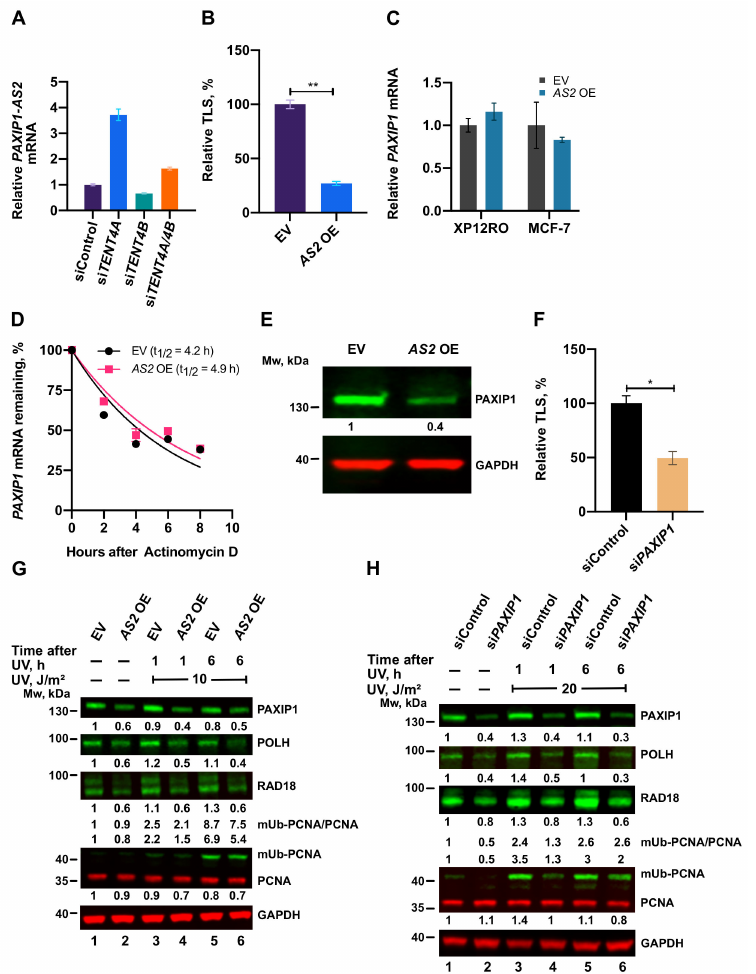
Figure 7. Involvement of PAXIP1-AS2 and PAXIP1 in TLS. ( A ) Expression of TENT4A and/or TENT4B . B was knocked down for 48 h, after which the level of PAXIP1-AS2 transcript was measured by qPCR, normalized to GAPDH , and compared to cells treated with siControl. The results are presented as the mean ± SEM of three independent experiments. ( B ) TLS across a cisPt-GG in MCF-7 cells in which PAXIP1-AS2 antisense RNA was overexpressed (See Supplementary Materials Tables S7 and S8). The results are presented as the mean ± SEM of two independent experiments. Statistical analysis was performed using the two-tailed Student’s t-test (** p < 0.01). ( C ) PAXIP1-AS2 antisense RNA was overexpressed in XP12RO or MCF-7 cells for 48 h, after which the amount of PAXIP1 mRNA was measured by qPCR, normalized to GAPDH and presented relative to cells transfected with an empty vector (EV). The results are presented as the mean ± SEM of three independent experiments. ( D ) PAXIP1-AS2 antisense transcript was overexpressed for 48 h in MCF-7 cells, after which PAXIP1 mRNA levels were determined as described in Figure 2. GAPDH was used as normalized